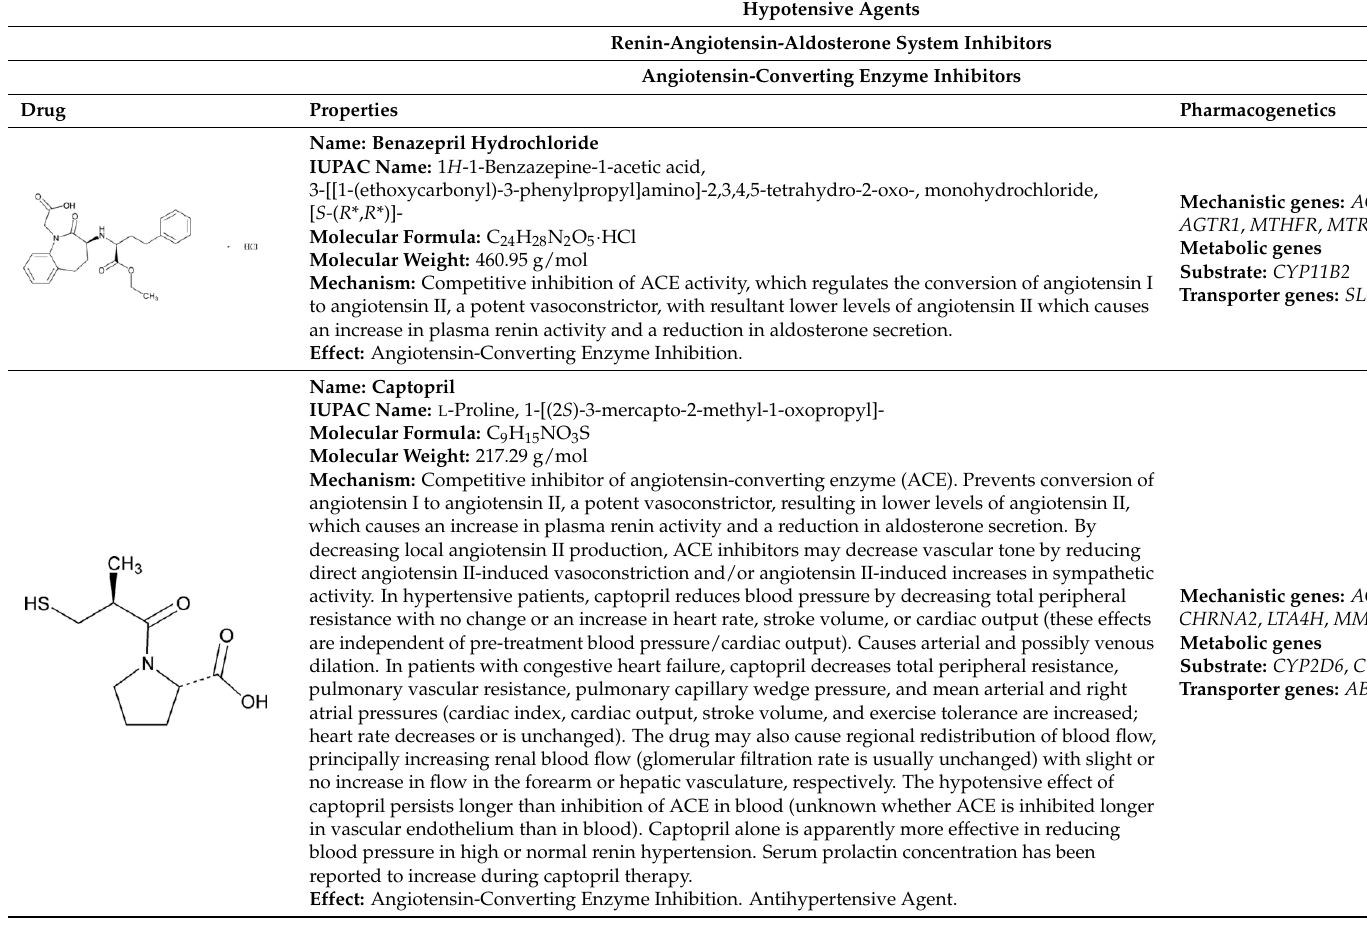
Table 2. Pharmacological profile and pharmacogenetics of angiotensin-converting enzyme (ACE) inhibitors and angiotensin II receptor antagonists.